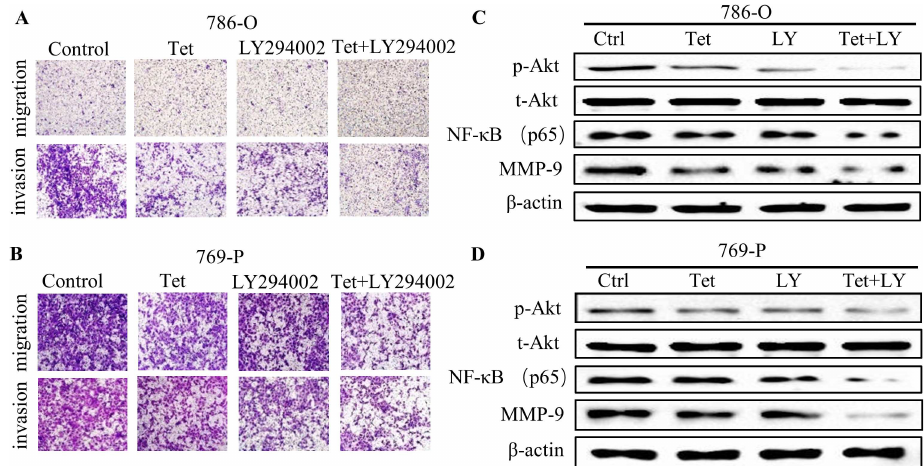
Fig 4. Tet inhibits RCC migration and invasion via decreasing Akt, NF- κ B and MMP-9 expression. The metastatic effects of 786-O ( A ) and 769-P ( B ) were detected by transwellassay under Tet treatment (0.5 μ M), with or without LY294002(LY, 20 μ M) for 24 h. The protein levels of Akt, phospho-Akt, NF- κ B and MMP-9 in 786-O ( C ) and 769-P ( D ) cells were detected after indicatedtreatments by western blotting. And the experiments were performed in